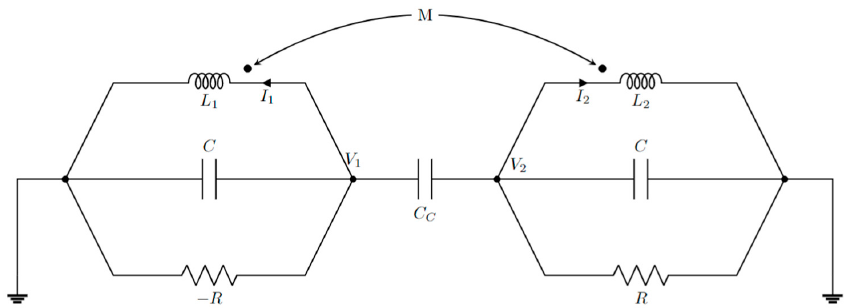
Figure 10. PT-symmetric electronic configuration realized with two coupled RLC resonators (proposed in [13]).